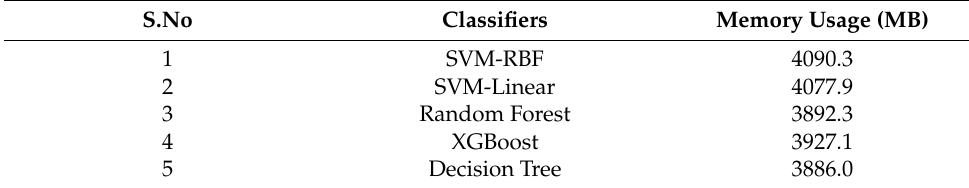
Table 8. Memory utilization of the machine learning classifiers on version 1 of the dataset.